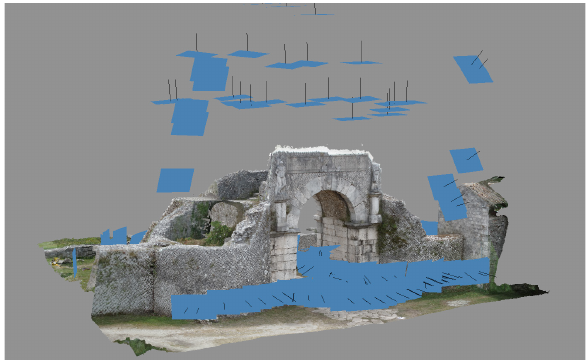
Figure 7. Photogrammetric model of Saepinum 's Porta Boiano.